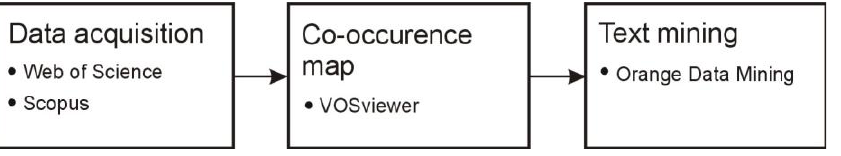
Figure 6. Research